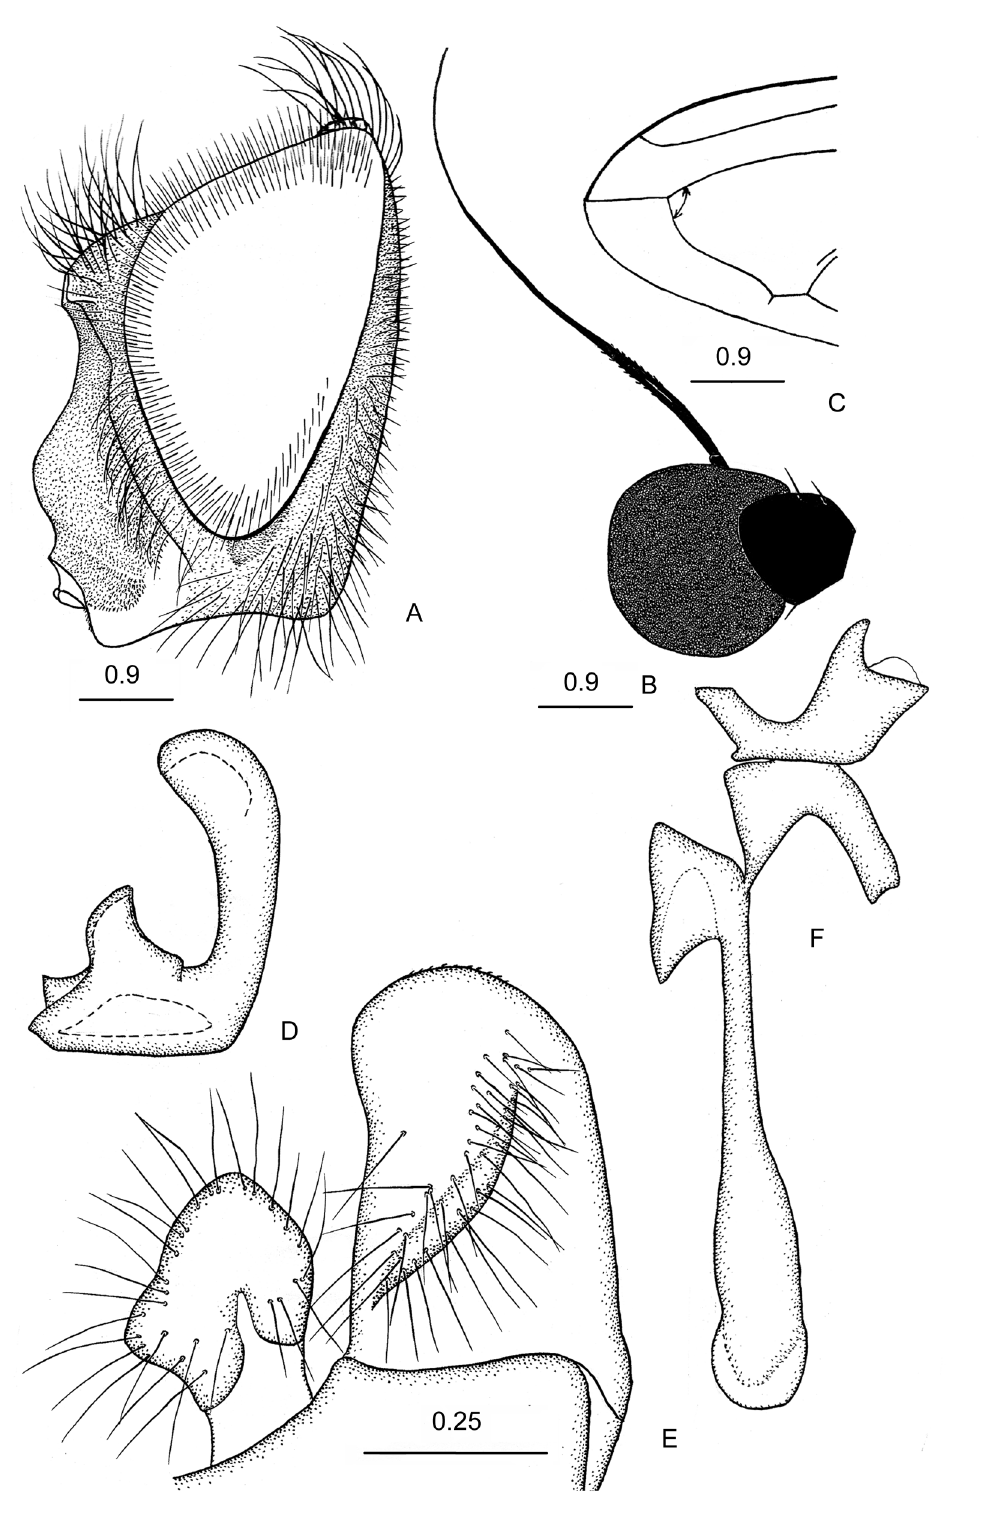
Fig. 63. Cheilosia ( Floccocheila ) vellea sp. nov., holotype, ♂ (IBSJW/NME). A . Head, lateral view. B . Antenna, lateral view of pedicel and basoflagellomere. C . Tip of wing. D . Superior lobe of hypandrium, lateral view. E . Surstylus and gonocercus, lateral view. F . Aedeagus and aedeagal apodeme, lateral view. Scale bars indicated in